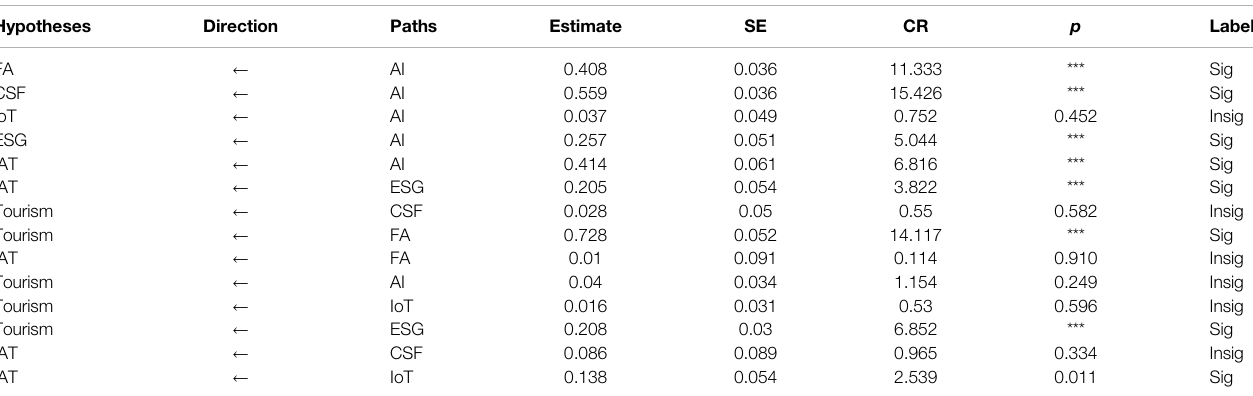
TABLE 4 | Hypothetical paths for arti fi cial intelligence and intelligent automation in tourism ( N = 402).